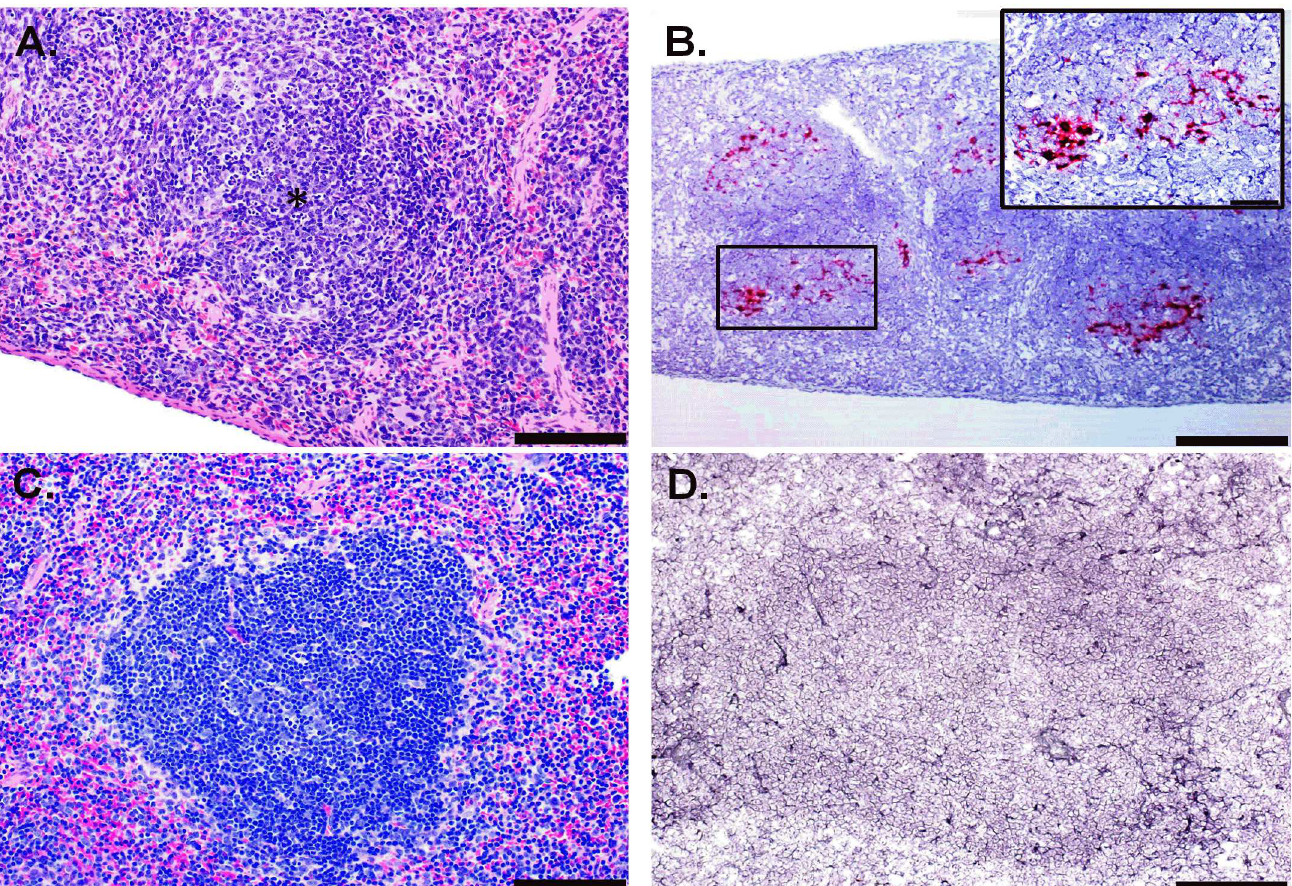
Fig 7. Histologic and ISH Findings in the Spleen of ZIKV-Infected Wild-type Mice Treated with an IFNAR1-Blocking MAb and Uninfected Control Mice. (A) Representative hematoxylin and eosin stainingshowedlymphocytolysis within the follicles(representative area indicatedwith an asterisk) in the spleenof a mouse exposedto ZIKV intraperitoneally (IP) that was euthanizedon day 11 post-infection (PI); scale bar represents 100 μ m. (B) Representative ISH stainingdemonstrating that multifocally,ZIKV RNA is detected in the lymphoidfolliclesin the spleen of a mouse exposedto ZIKV IP that was euthanized on day 11 PI; scale bar represents200 μ M (inset scale bar represents 50 μ m). (C) Representative hematoxylin and eosin staining in the spleen of an uninfectedcontrol mouse; scale bar represents 100 μ m. (D) Representative ISH stainingdemonstrating no ZIKV RNA is detected in the spleen of an uninfectedcontrol mouse; scale bar represents 100 μ m. These findings are from one independent experiment where a total of 8 ZIKV-infected mouse spleens(3 uninfectedcontrols) were analyzedby an unblinded,board-certified veterinary pathologist.